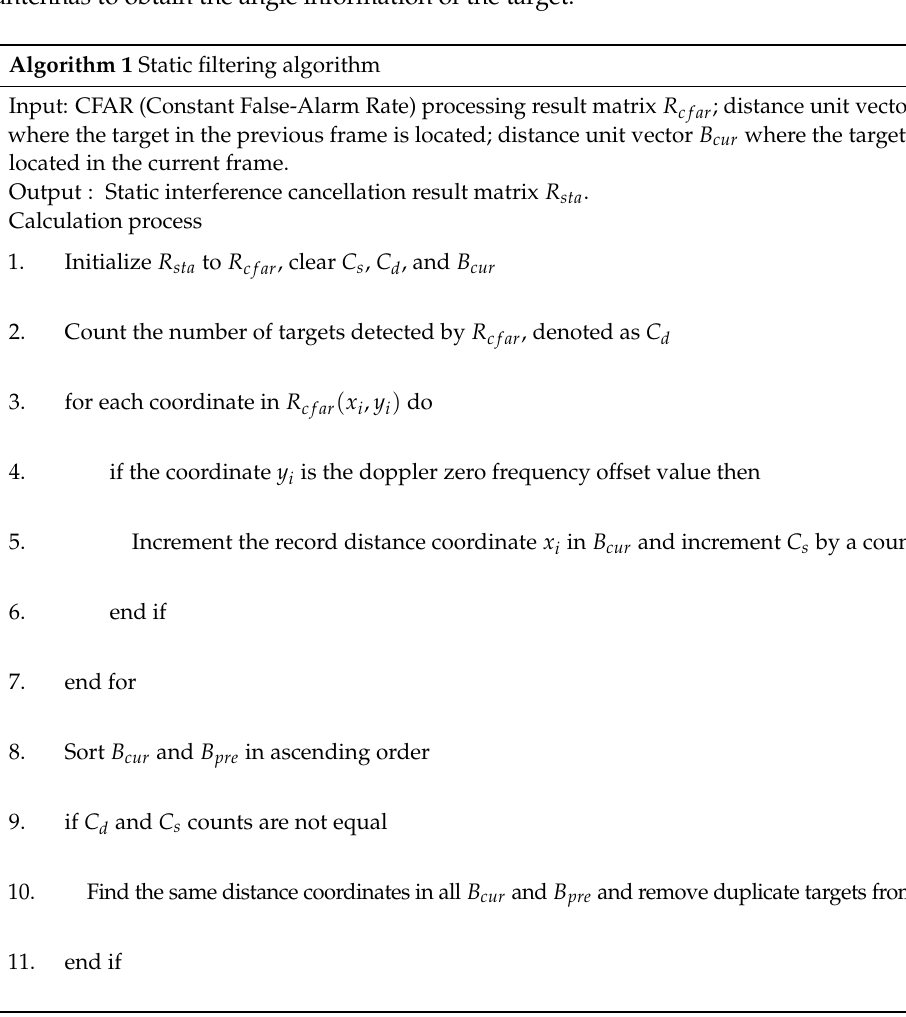
Algorithm 1 Static filtering